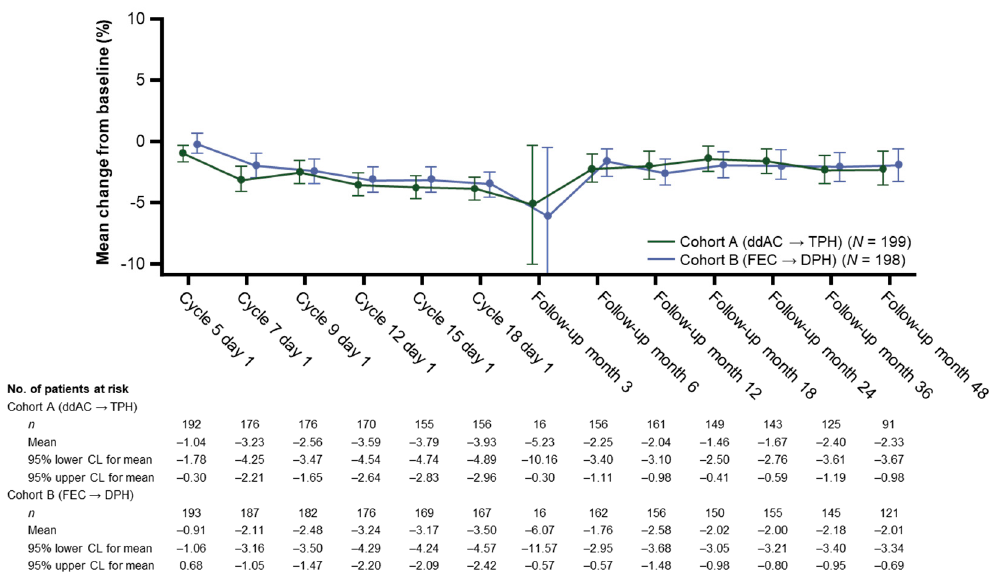
Figure 1. Mean change in left ventricular ejection fraction by visit. CL, confidence limit; ddAC, dose-dense doxorubicin plus cyclophosphamide; DPH, docetaxel, pertuzumab, and trastuzumab; FEC, fluorouracil, epirubicin, and cyclophosphamide; TPH, paclitaxel, pertuzumab, and trastuzumab.